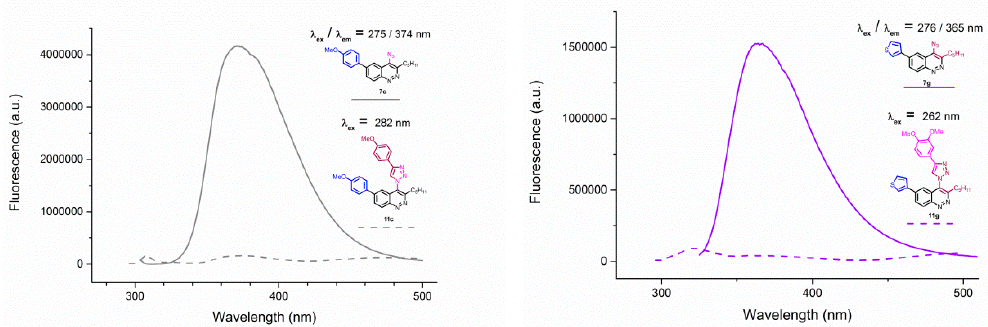
Figure 5. Emission spectra of 4-azidocinnolines / 4-triazolylcinnolnes 7c / 11c (left) and 7g / 11g (right) solutions in THF, C = 1 × 10 − 5 mol / L.